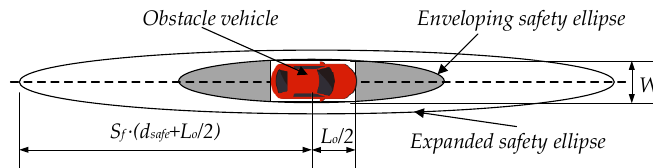
Figure 10. The improved vehicle constraint.